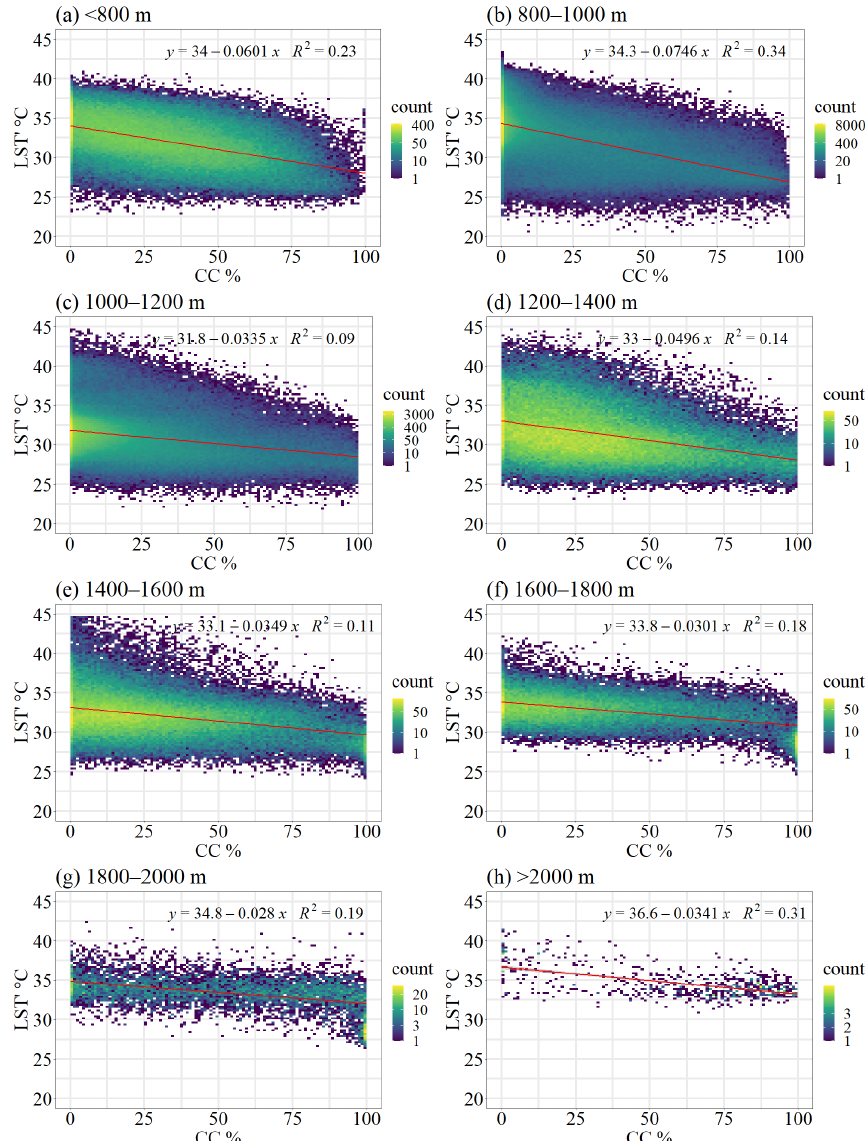
Figure 7. Density plots of topographically corrected land surface temperature (LST (cid:48) ) and canopy cover (CC) percentage in eight elevation classes with regression line. (a) Below 800m. (b) 800–1000m. (c) 1000–1200m. (d) 1200–1400m. (e) 1400–1600m. (f) 1600–1800m. (g) 1800–2000m. (h) Above